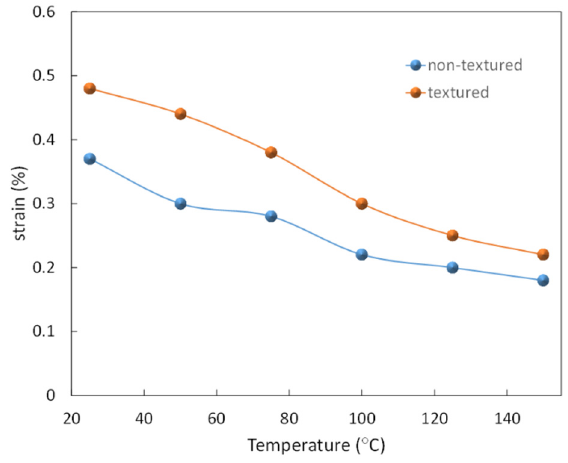
Figure 13. Temperature dependence of the strain for 0.91Bi 0.5 Na 0.5 TiO 3 –0.06BaTiO 3 –0.03AgNbO 3 textured vs. non-textured ceramics (After Zhang, et al. [134]).